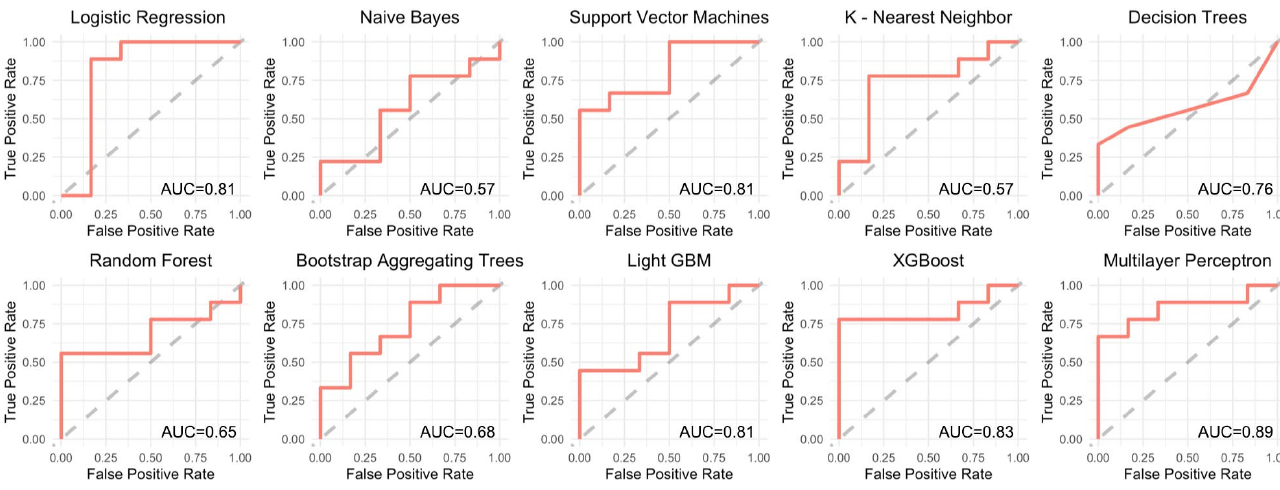
Figure 5. The combination of six candidate genes/8 CpG sites with different machine learning models. AUC values listed in right lower corner ranged from 0.57~0.89. Table 3. The performance metrics of machine learning models.